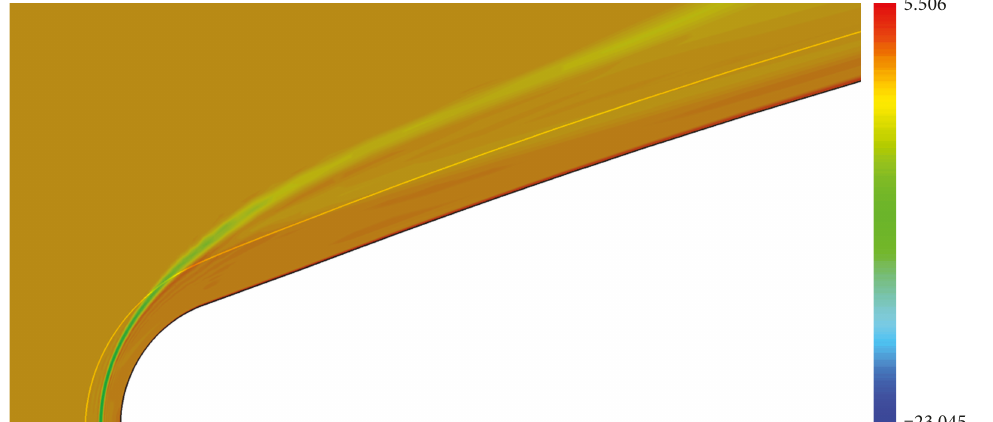
Figure 9: Total enthalpy percent error (ht/ht ∞ -1)% (model